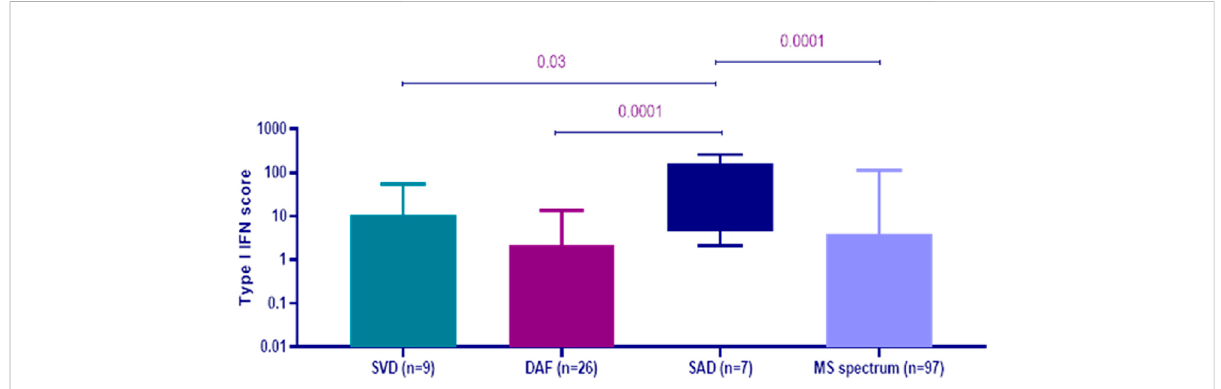
FIGURE 1 Peripheral blood type I interferon (IFN) scores at fi rst evaluation according to the fi nal diagnosis at 1 year of follow-up. Patients with systemic autoimmune disease (SAD) with central nervous system (CNS) involvement (n = 7) had higher type I IFN score at baseline [median (IQR): 50.18 (152.50)] compared to those with small vessel disease (SVD, n = 9) [median (IQR): 0.68 (12.56), p-value: 0.03], demyelinating disease with autoimmunefeatures(DAF,n=26)[median(IQR): 0.23(4.40),p-value: 0.0001]andmultiplesclerosis(MS)spectrumdisorders(n =97)[median (IQR): 0.64 (6.75), p-value: 0.0001]. Error bars represent the minimum and maximum of data